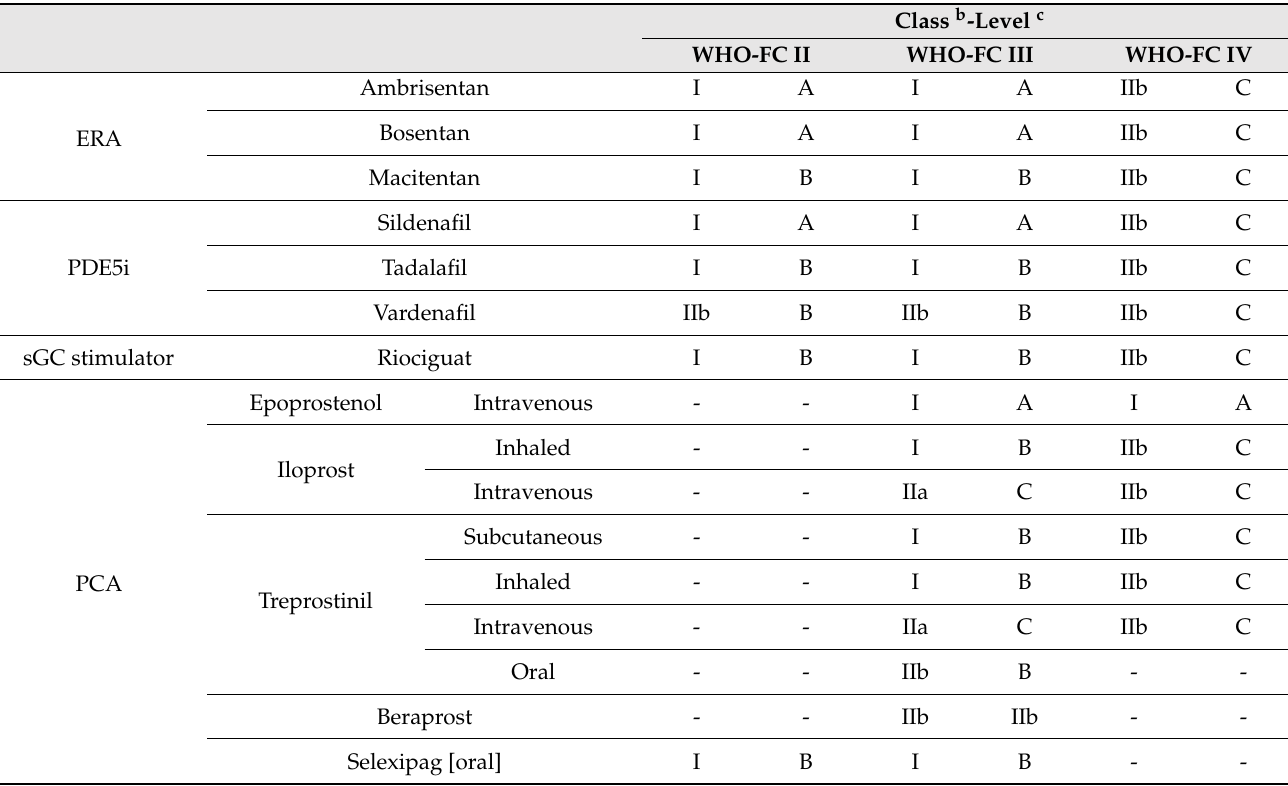
Table 3. Efficacy of drug monotherapy for group 1 PAH according to WHO functional class a